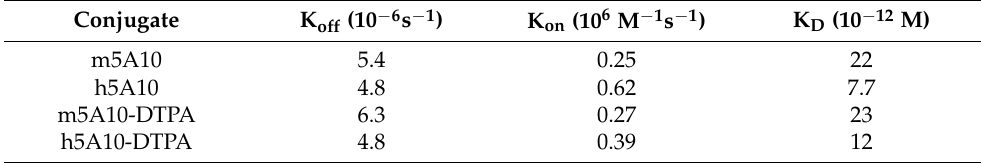
Figure 2. ( a ) The purity and possible aggregation of h5A10 analyzed by size exclusion chromatography (SEC) analysis, at 37 °C ( b ) The possible cross − reactivity of h5A10 towards hK2 was analyzed by ELISA. ( a ) The purity of h5A10 by SEC analysis. ( b ) Cross- reactivity of h5A10 towards hK2 by ELISA. Table 1. Binding kinetics and affinities by surface plasmon resonance